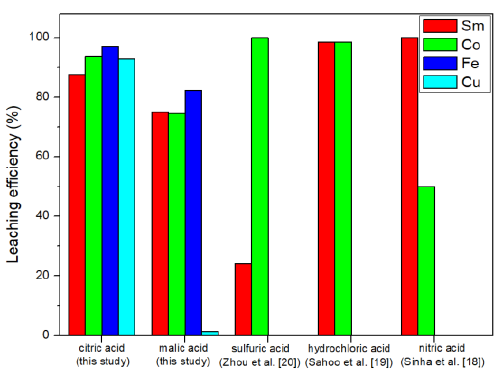
Figure 5. Comparison of leaching efficiencies.